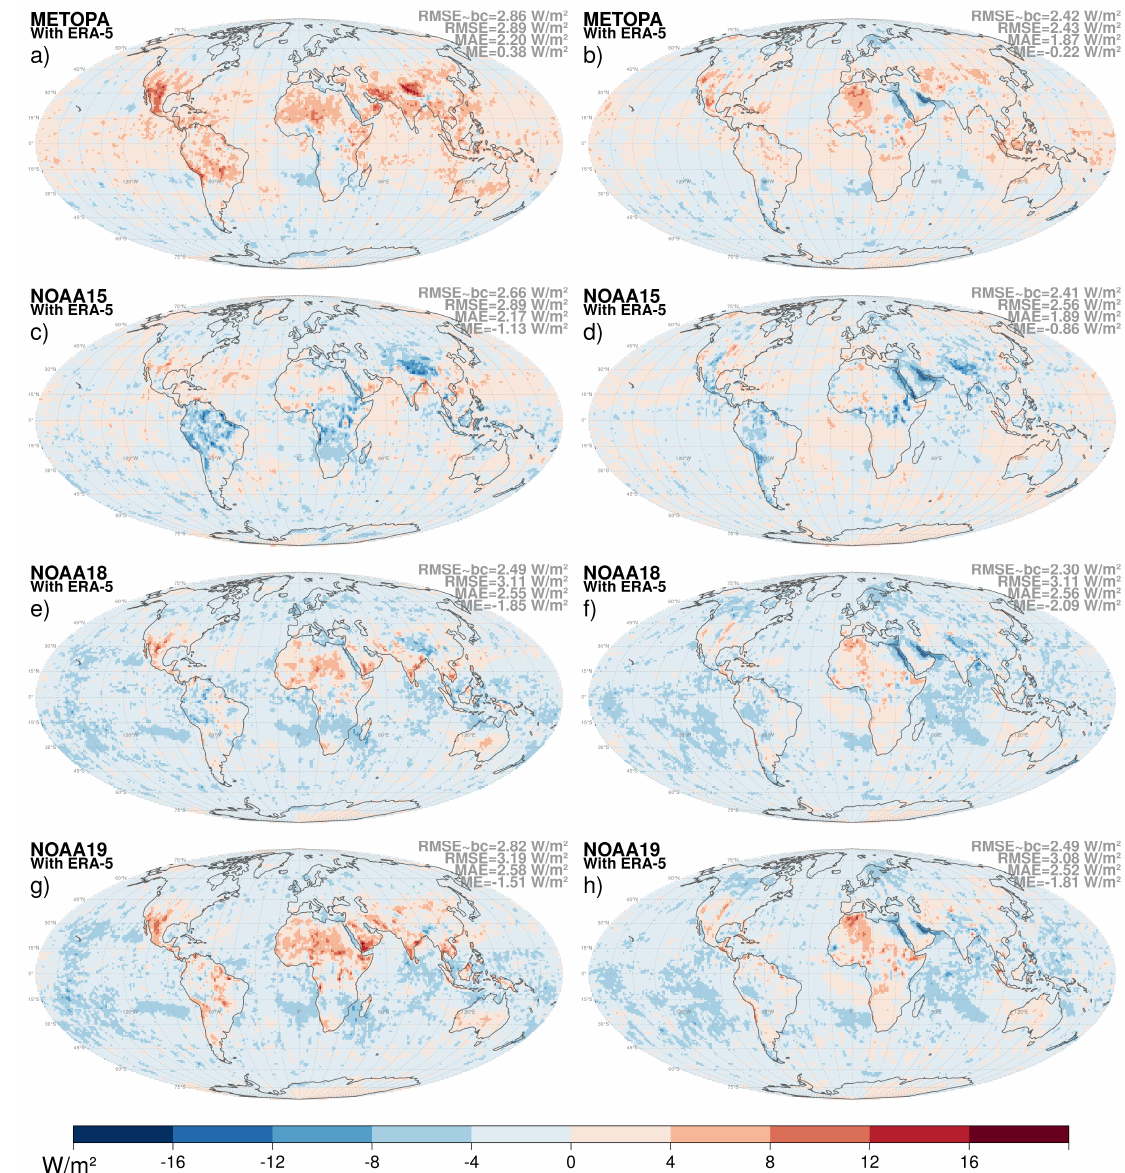
Figure 10. Monthly mean OLR difference with respect to CERES SYN1deg for April 2012 ( left ) and June 2012 ( right ) based on a single satellite, with figure rows representing satellites METOP-A ( a , b ), NOAA-15 ( c , d ), NOAA-18 ( e , f ) and NOAA-19 ( g,h